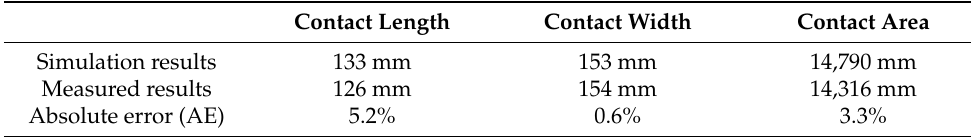
Figure 9. Footprint of the tire: ( a ) measured result; ( b ) simulation result. Table 2. Comparison of the tire